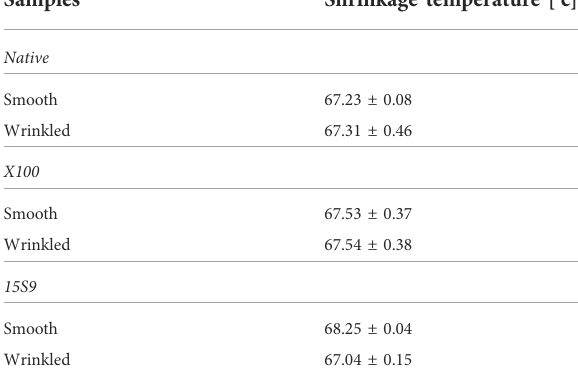
TABLE 1 Shrinkage temperatures detected for the investigated